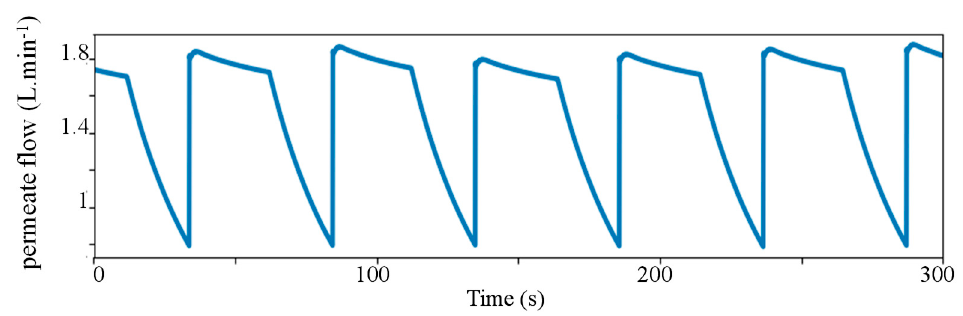
Figure 16. Permeate-simulated flow rate over time, considering a constant thermal power at the evaporator.